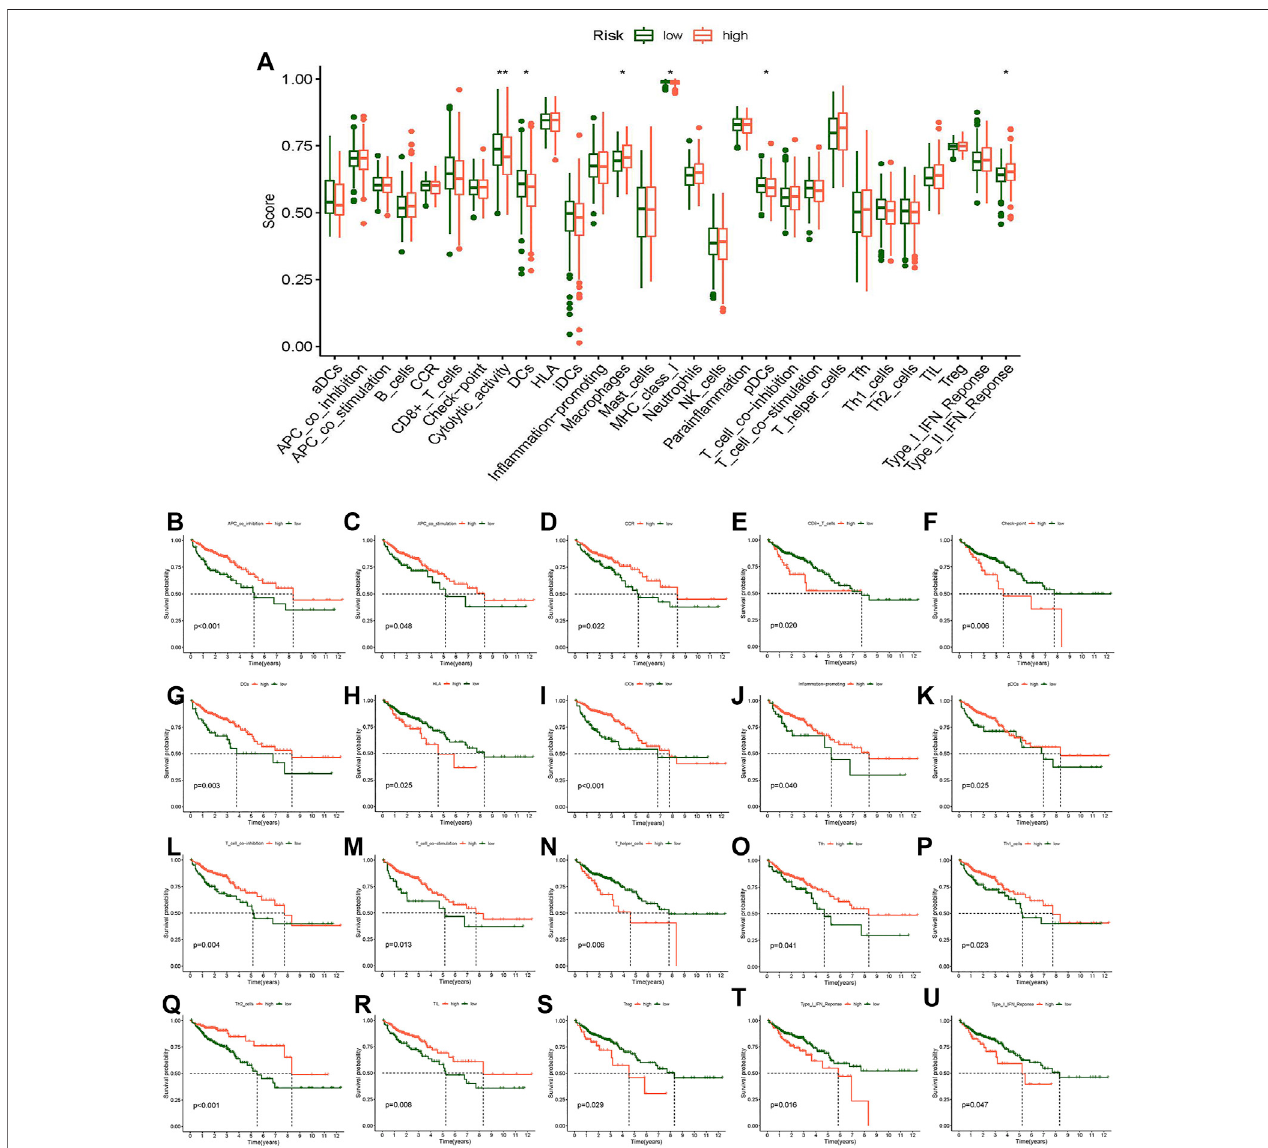
FIGURE 9 | Analysis of the difference in immune-related function and survival analysis. (A) Boxplot of the difference of immune-related function. (B) Kaplan – Meier survivalanalysisinAPCco-inhibition. (C) Kaplan – MeiersurvivalanalysisinAPCco-stimulation. (D) Kaplan – MeiersurvivalanalysisinCCR. (E) Kaplan – Meiersurvivalanalysis in CD8 + T cells. (F) Kaplan – Meier survival analysis in checkpoint. (G) Kaplan – Meier survival analysis in DCs. (H) Kaplan – Meier survival analysis in HLA. (I) Kaplan – Meier survivalanalysisiniDCs. (J) Kaplan-Meiersurvivalanalysisinin fl ammation-promoting. (K) Kaplan – MeiersurvivalanalysisinpDCs. (L) Kaplan – Meiersurvivalanalysisin Tcellco-inhibition. (M) Kaplan – MeiersurvivalanalysisinTcellco-stimulation. (N) Kaplan – MeiersurvivalanalysisinThelpercells. (O) Kaplan – MeiersurvivalanalysisinTfh. (P) Kaplan – Meier survival analysis in Th1 cells. (Q) Kaplan – Meier survival analysis in Th2 cells. (R) Kaplan – Meier survival analysis in TIL. (S) Kaplan – Meier survival analysis in Tregs. (T) Kaplan – Meier survival analysis in Type I IFN response. (U) Kaplan – Meier survival analysis in Type II IFN response. * p < 0.05, ** p < 0.01, *** p <